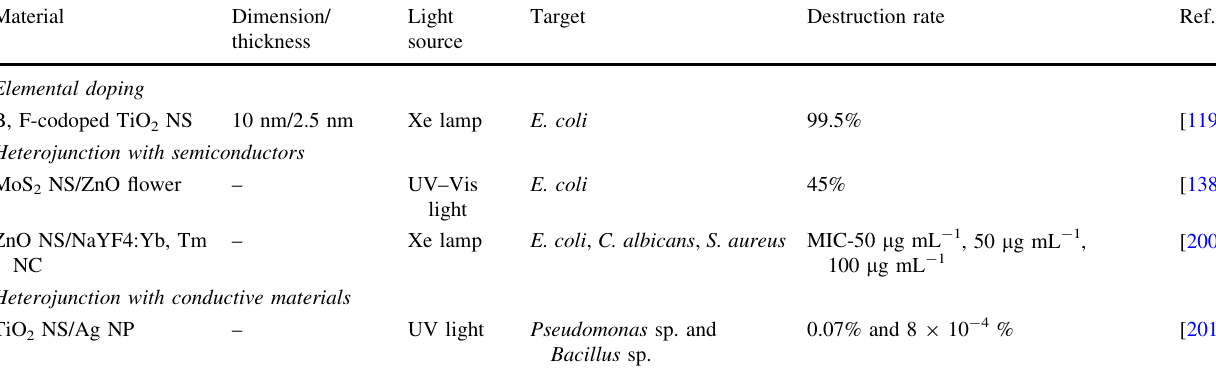
Table 6 Summary of antimicrobial disinfection performances of 2D TMO&Cs and their compounds